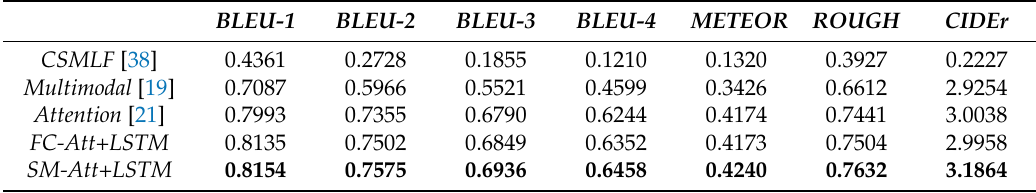
Table 2. Results of the baseline and our methods on the UCM Dataset.